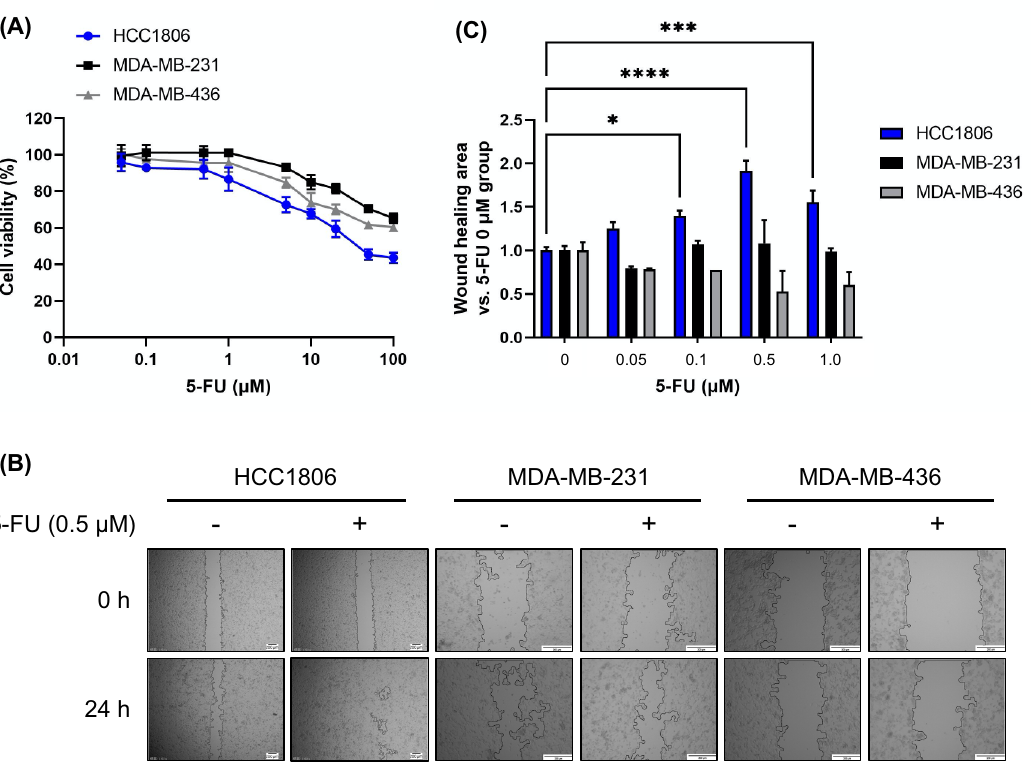
Figure 1. Fluorouracil (5-FU) increased cell mobility in HCC1806 cells. ( A ) Cells were treated with 0.1– 100 μM 5-FU for 24 h and cell viability was determined by WST-8 assay. Data are represented as mean ± SD; n = 5. ( B ) Cells were seeded in 24-well plates. A scratch was made in the cell monolayer and then the monolayer was treated with 0.5 μM 5-FU for 24 h. Images of the wound area at the beginning and end of the treatment period were recorded. Scale bars = 200 μm. ( C ) Cells were seeded in 24-well plates. A scratch was then made in the cell monolayer and the monolayer was treated with 0.05–1 μM 5-FU for 24 h. ImageJ software was used to calculate the relative healing area. Data are presented as mean ± SD; n = 3. * P < 0.05; *** P < 0.001; **** P < 0.0001. Results are representative of two independent